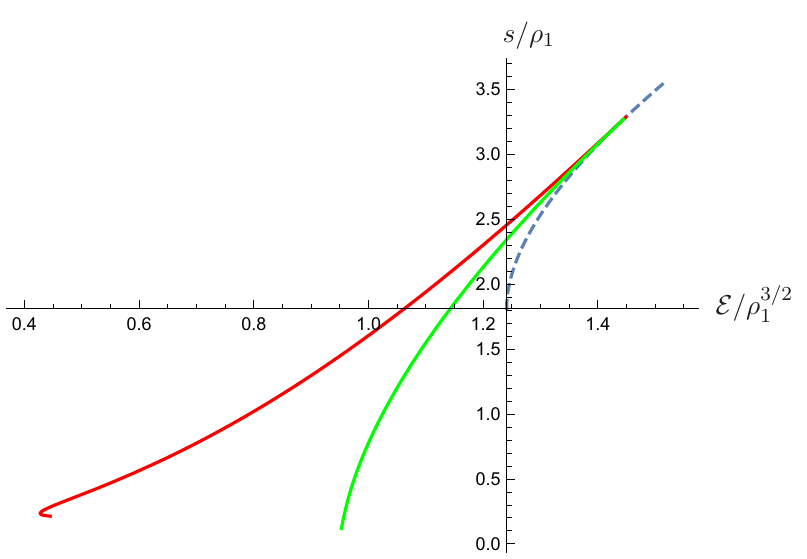
in model DG-A (green curve), E